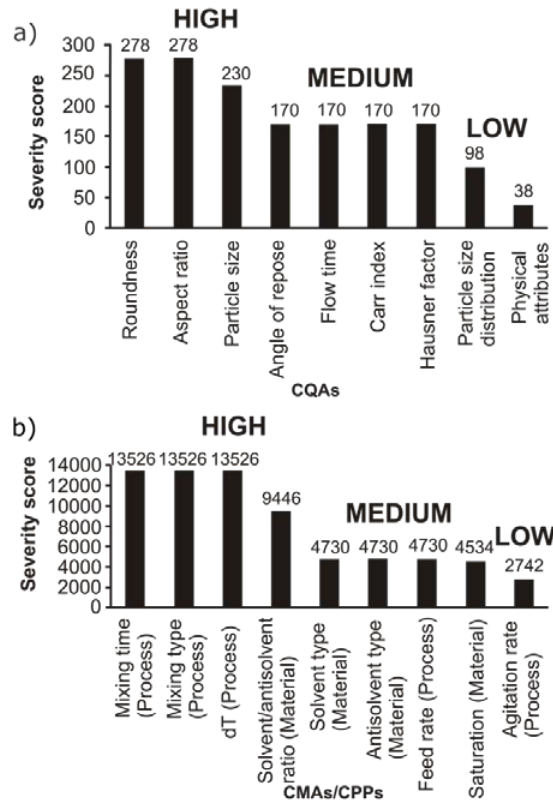
Figure 4. Pareto diagrams of the CQAs ( a ) and the CMAs/CPPs ( b ). Low = low-risk parameter; Medium = medium-risk parameter; High = high-risk parameter.